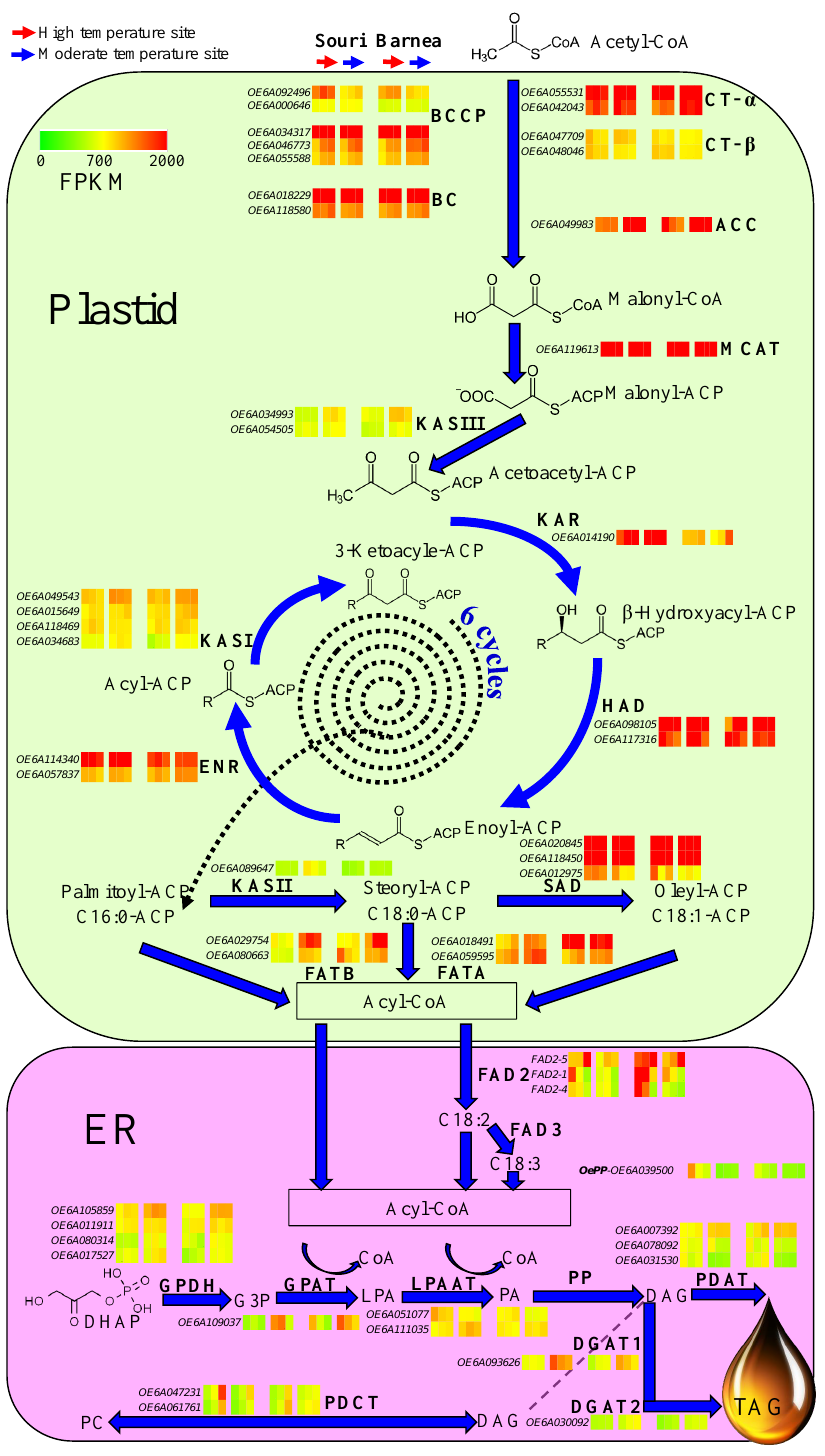
Figure 2. Expression pattern of the genes involved in the olive oil biosynthesis pathway in fruit from the HT site compared to that of fruit grown in the MT environment. Expression levels for each gene are presented in a green to red scale above or beside the name of the enzyme. For each enzyme, only